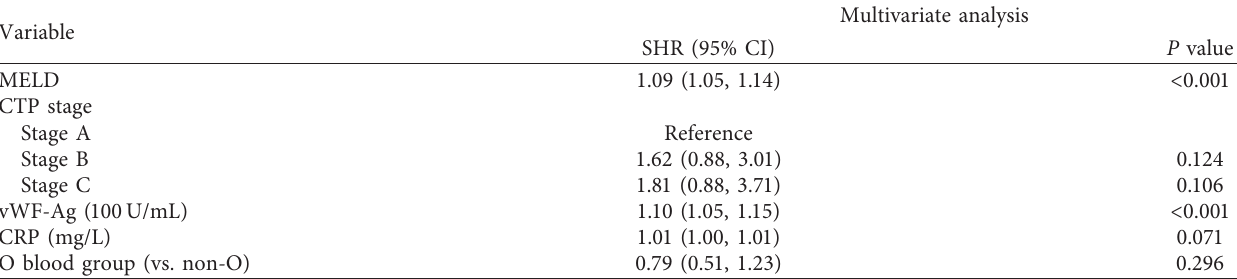
Table 3: Multivariate analysis for transplant-free mortality in competing risk